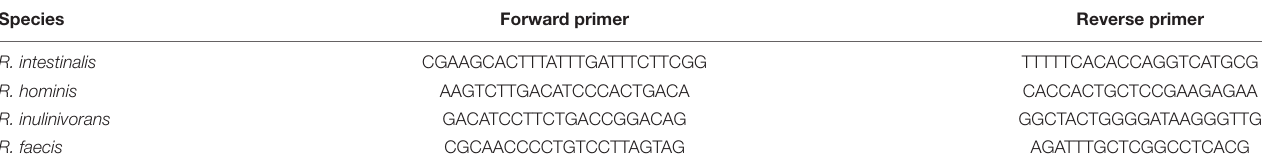
TABLE 2 | Primers used in qPCR quantification of Roseburia species. Species Forward